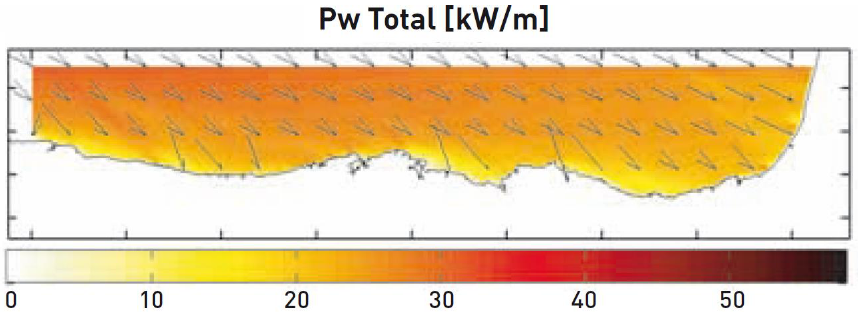
Figure 13. Annual average wave power, in kW/m, in the west part of the Area I (Cantabrian coast) (Reproduced with permission from [73]. IDEA, 2019). Table 2. Annual average wave power, in kW/m, in all the areas in the Spanish coast.